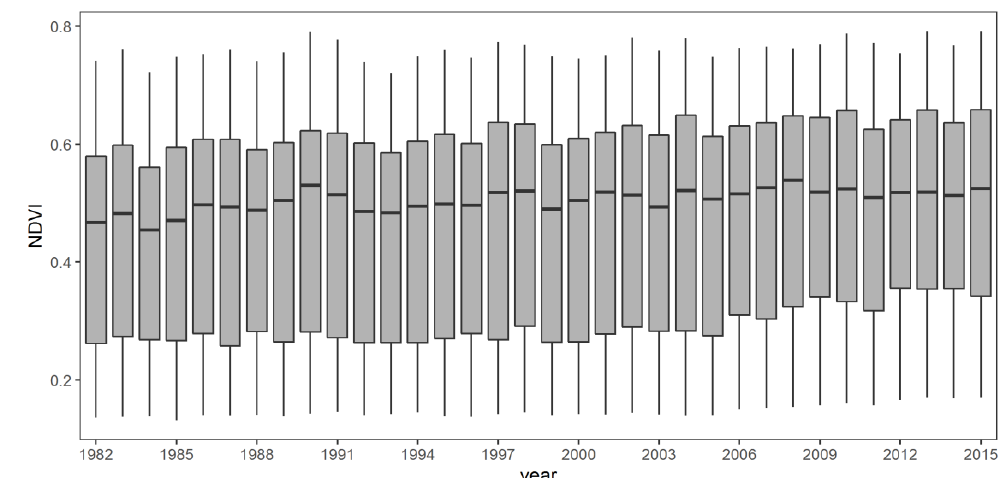
Figure 2. The boxplot of inter-annual variation of NDVI in Shaanxi Province during 1982–2015 (Each box denotes data distribution represents the NDVI data distribution of the whole Shaanxi Province in that year. The line that divides the box into 2 parts represents the median of the data. The end of the box shows the upper (75%) and lower (25%) quartiles).